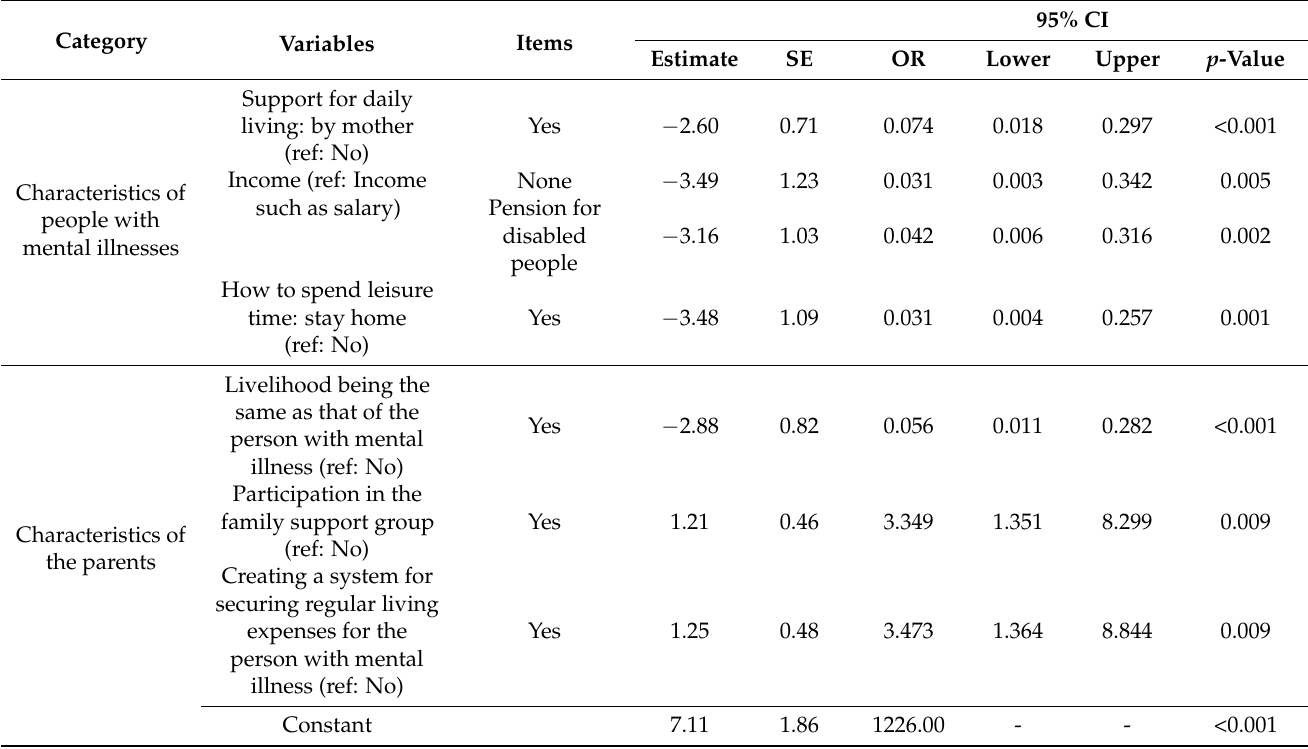
Table 3. Results of the logistic regression with the dependent variable for whether or not people with mental illness can live independently ( N =